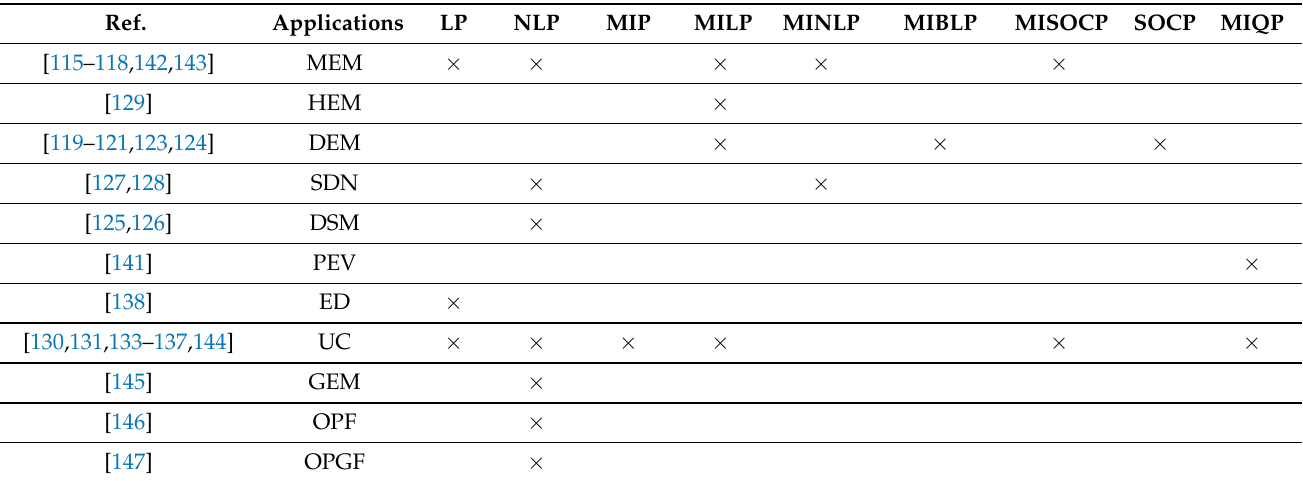
Table 5. Application of chance constrained optimization and its problem type.